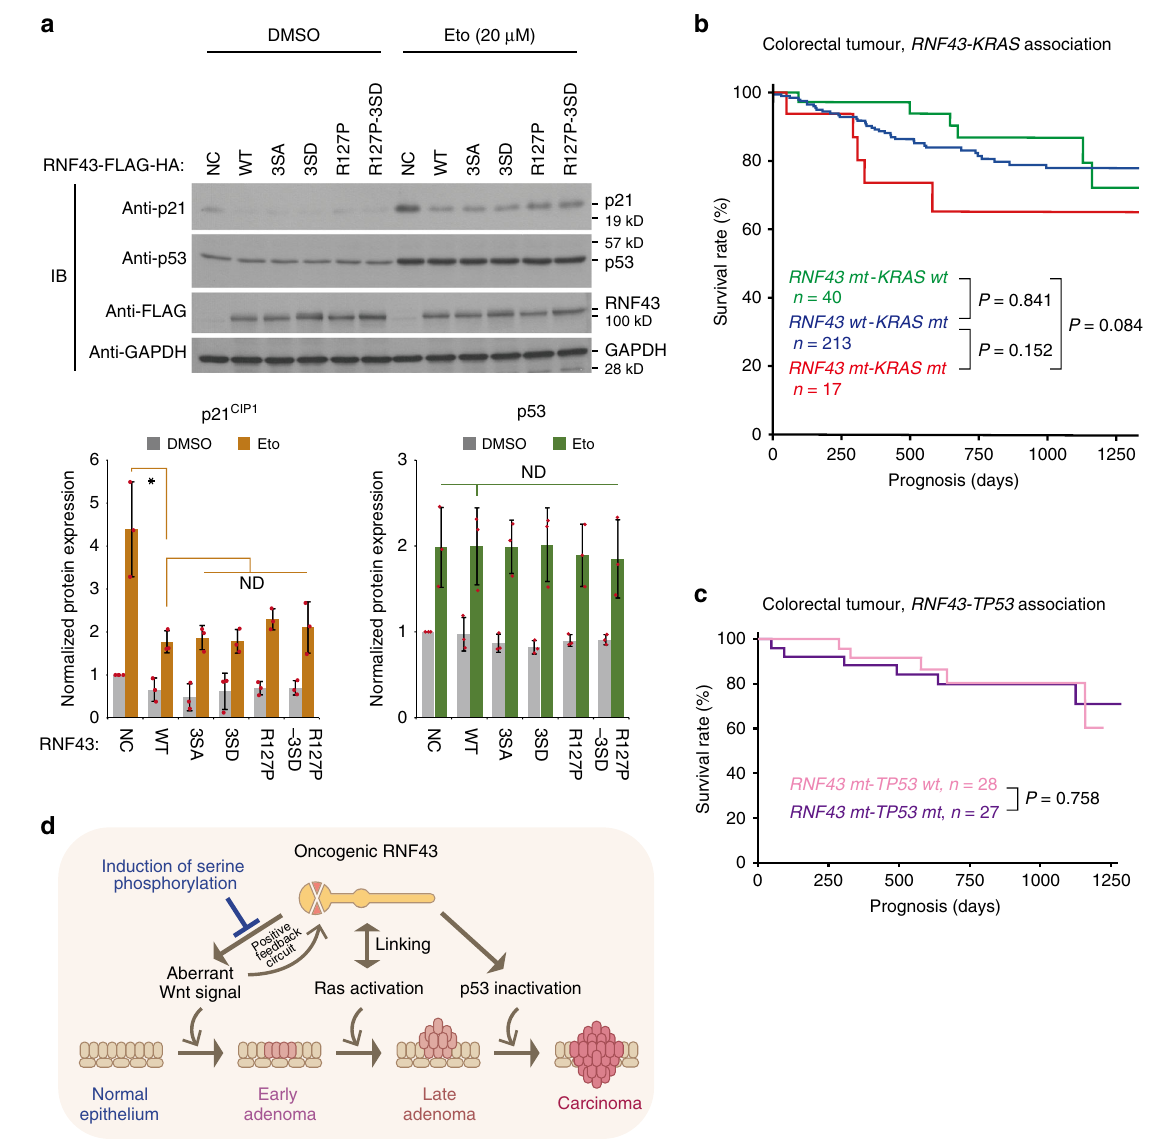
Fig. 5 Cooperation of mutant RNF43 with active Ras establishes Wnt-Ras-p53 axis. a Induction of p53 and p21 protein was examined by immunoblotting (IB) with Eto treatment. Expression of p53 and p21 in empty vector-transfected NC cells with DMSO treatment was set to 1. Bar graphs and error bars represent mean ± sd. Red circles indicate individual values of each sample. Asterisks indicate signi fi cant differences from NC cells stimulated with Eto ( P < 0.05, one-way ANOVA, n = 3 biological replicates). ND indicates no signi fi cant difference. b , c Prognosis of patients with colorectal tumour that carry genetic mutations in RNF43 with or without KRAS ( b ) or in RNF43 with or without TP53 ( c ) is shown. Sample number and P value determined by log-rank test ( b , c ) with Holm adjustment for multiple comparisons ( b ) are indicated in each graph. d Schematic of biological role of RNF43 oncogenic mutations in multi-step tumorigenesis. Oncogenic RNF43 mutants that promote Wnt signalling and inhibit the p53 pathway cooperate with activating Ras mutations to complete all the steps of multi-step colorectal